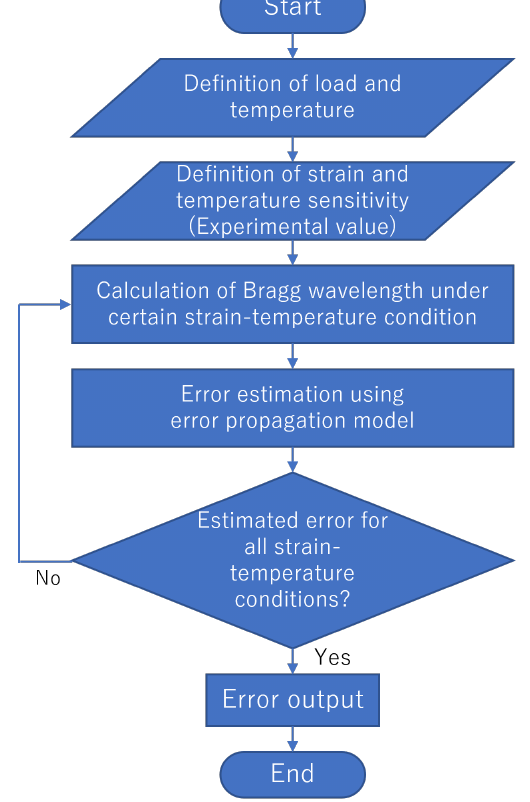
Figure 9. Flow of the error output when using an error propagation model.